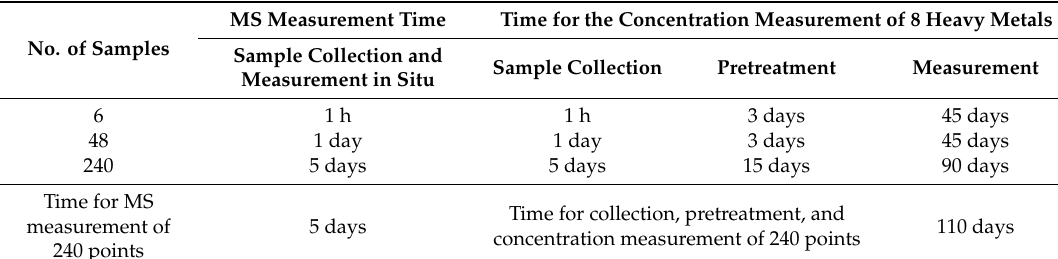
Table 7. Time for determining MS and the concentration of 8 heavy metals in 240